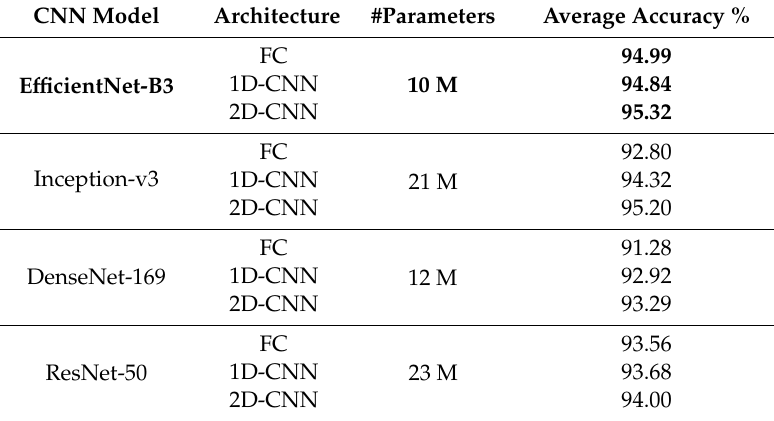
Table 7. Classification Accuracy using di ff erent pre-trained CNN models. We used Inception-v3, DenseNet-169, and